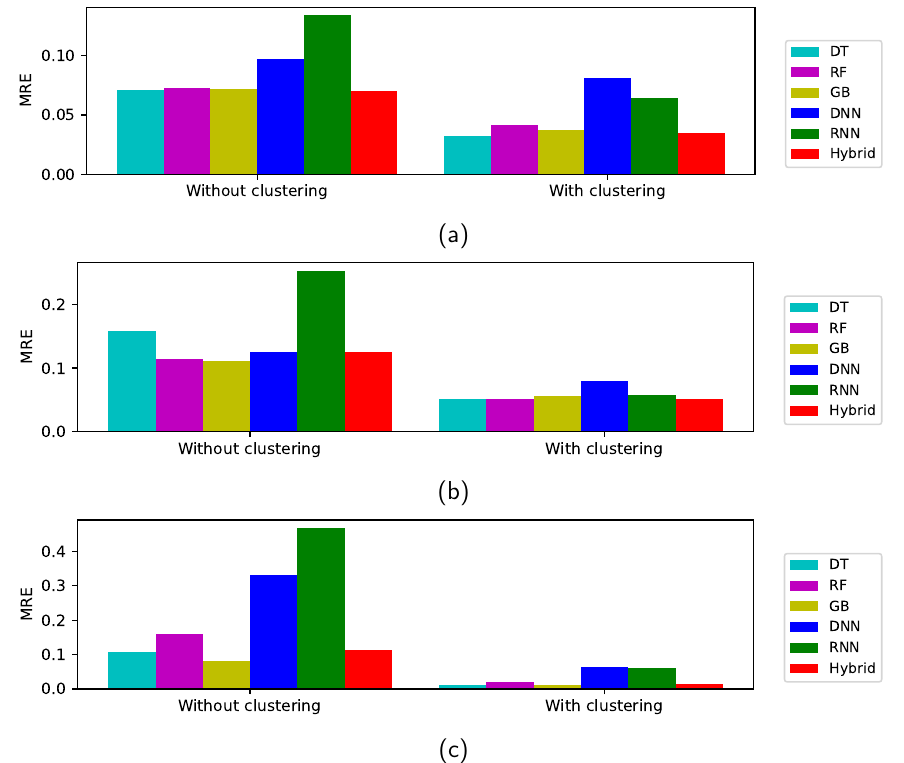
Figure 14. MRE of the test data with and without clustering for ( a ) Zener diodes, ( b ) varactors, and ( c ) bridge rectifier diodes. Table 10 lists the RMSRE errors of the training data with and without clustering.